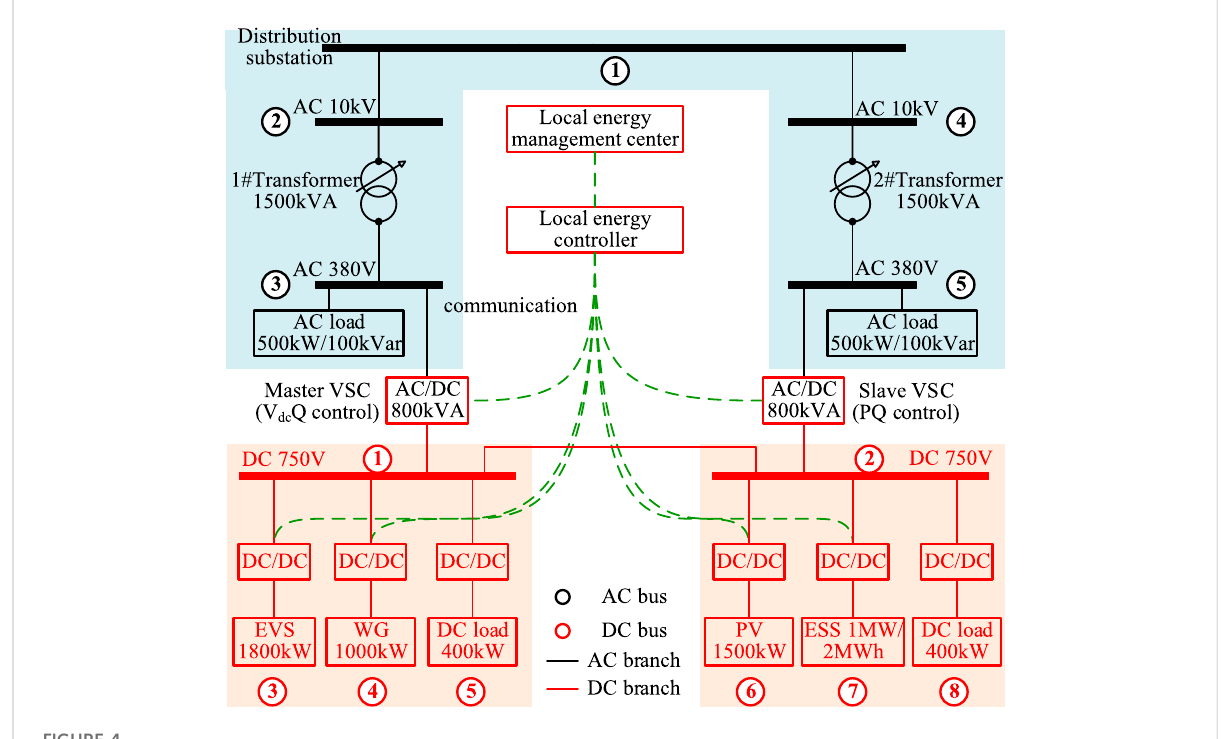
FIGURE 4 Con fi guration of the tested fl exible